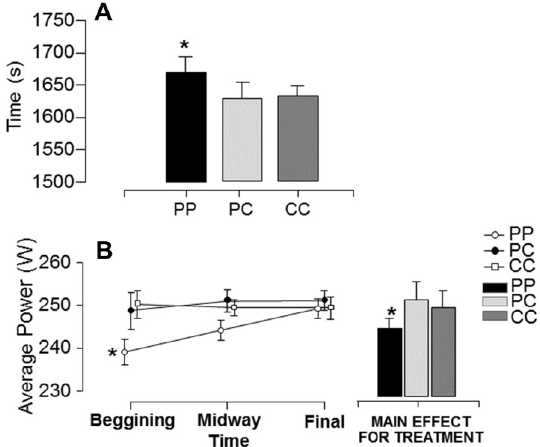
Figure 2. ( A ) Mean ± SE of time to execute the TT-test with 3 experimental conditions: Placebo-Placebo (PP), Placebo-Caffeine (PC) and Caffeine-Caffeine (CC). (*) Significantly different from other experimental conditions ( P < 0.05). ( B ) Mean ± SE of average power output (W) with 3 experimental conditions: Placebo- Placebo (PP), Placebo-Caffeine (PC) and Caffeine-Caffeine (CC) in three different moments of the TT-test. (*) Significantly different from other experimental conditions ( P <